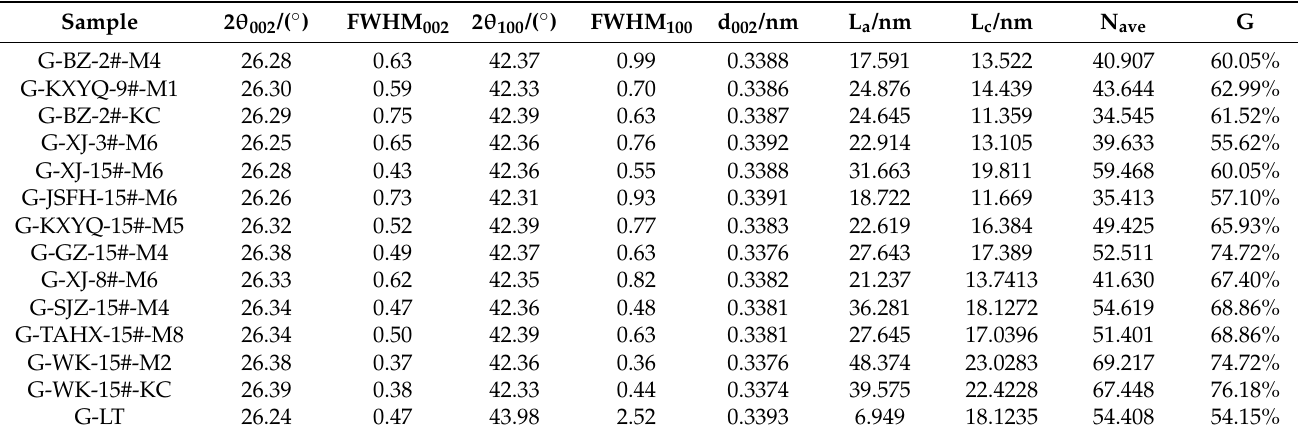
Figure 1. XRD patterns of coal-based graphite. Table 3. XRD parameters of coal-based graphite.